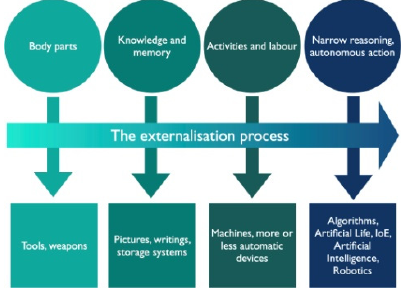
Figure 3. The externalization process.